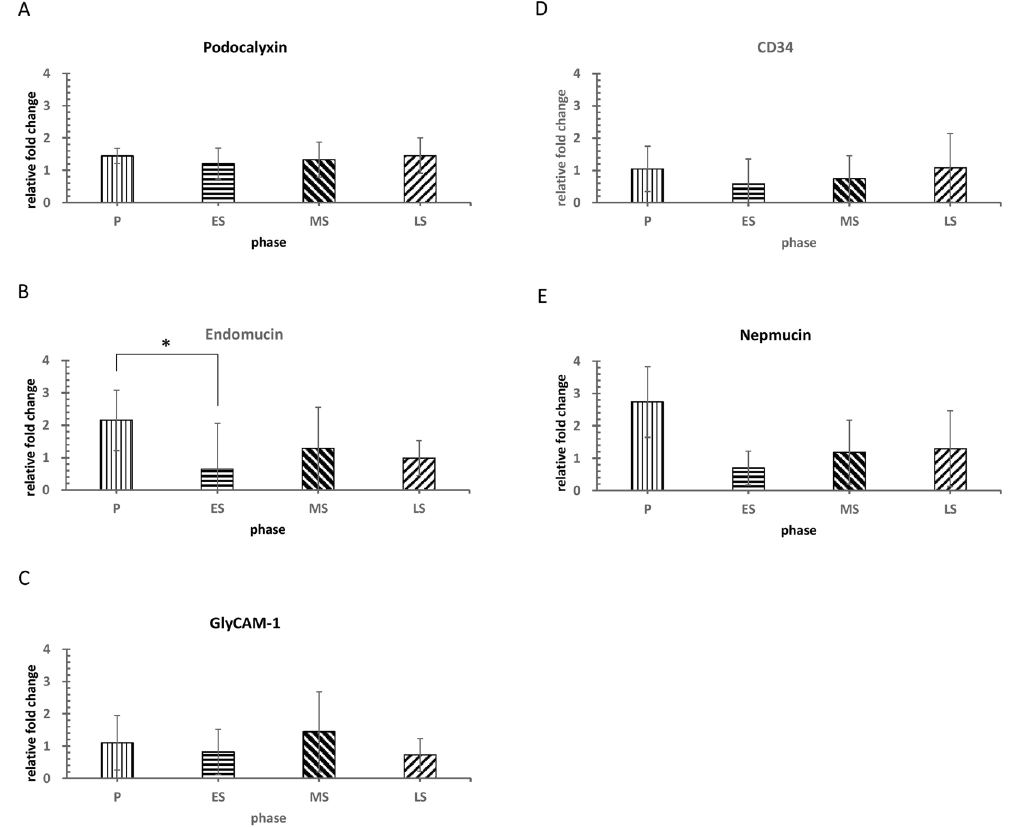
Figure 3. The expression patterns of LSL peptide component genes in the four phases of the menstrual cycle. The gene expression of LSL peptide components revealed variation among the four phases. The relative fold changes of endomucin, nepmucin, and CD34 are higher in the proliferative phase ( B , C and D ). There is a significant difference in relative fold changes in endomucin between the proliferative and early secretory phases (P < 0.05) ( B ). Results are expressed as mean ± SE. Statistical significance was assessed by the Kruskal-Wallis test ( * p < 0.05). P: proliferative phase; ES: early-secretory phase; MS: mid-secretory phase; LS: late-secretory